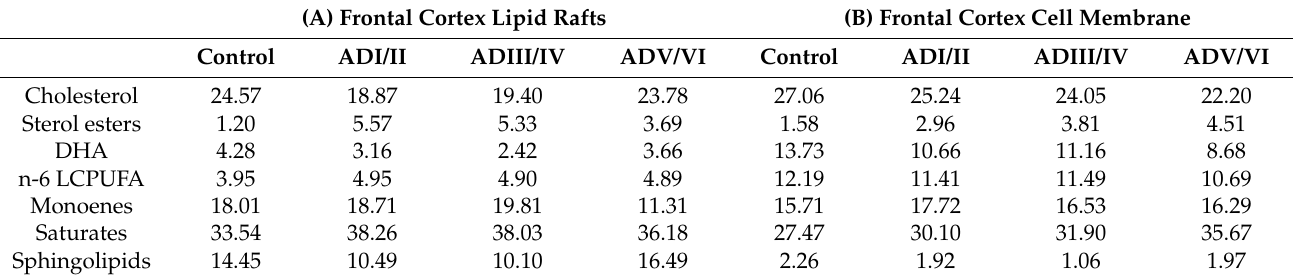
Table 1. Lipid class composition of frontal cortex cell membrane and lipid rafts from experimental measurements. Values are expressed as % of total lipid